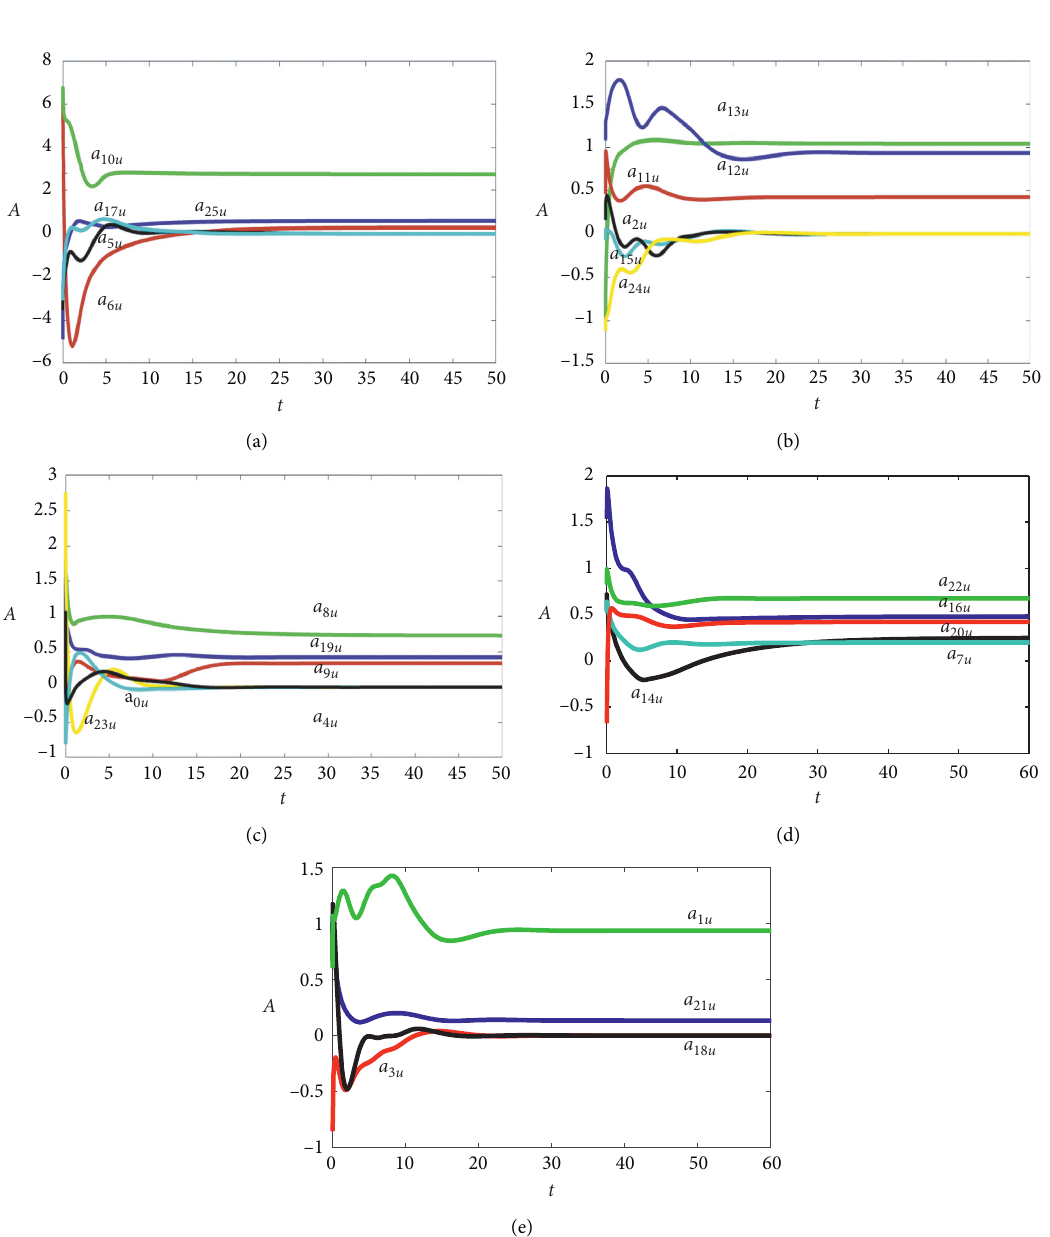
, a , ... ,a for neural network (53) and (54) in Example 1. 0 u 1 u 25 u